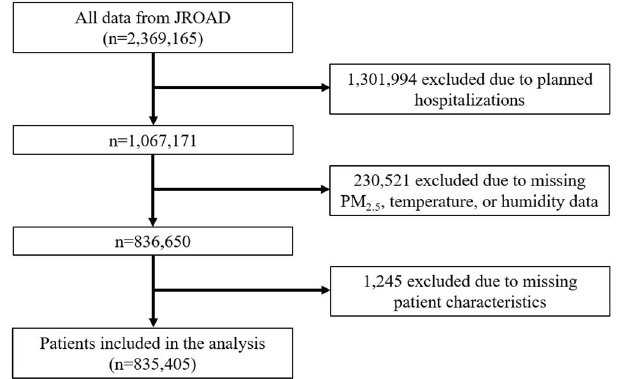
Figure 2. Study flow chart. This study included a large data set of patients from the Japanese Registry Of All cardiac and vascular Diseases (JROAD) obtained through the Japanese administrative case-mix Diagnostic Procedure Combination (DPC)